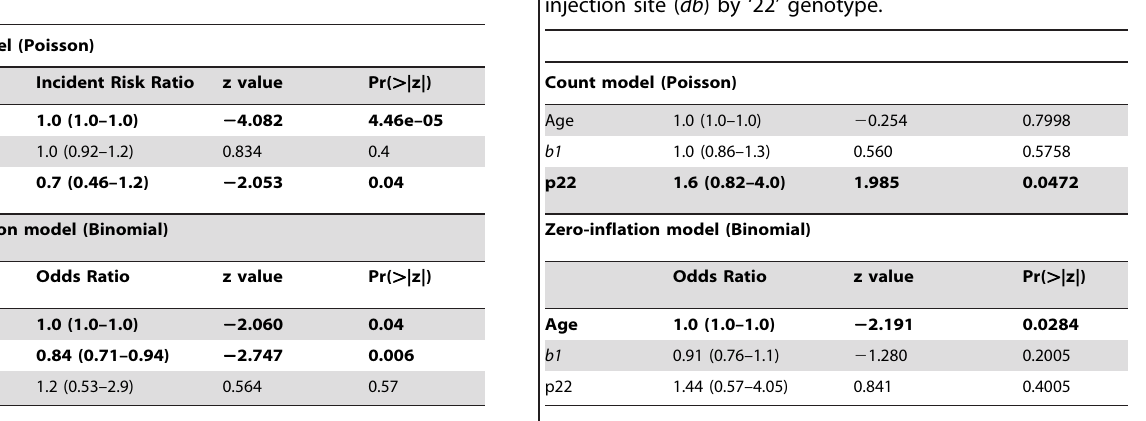
Table 3. Prediction of difference in swelling size between initial and final measurements at the avian tuberculin injection site ( da ) by ‘22’ genotype.